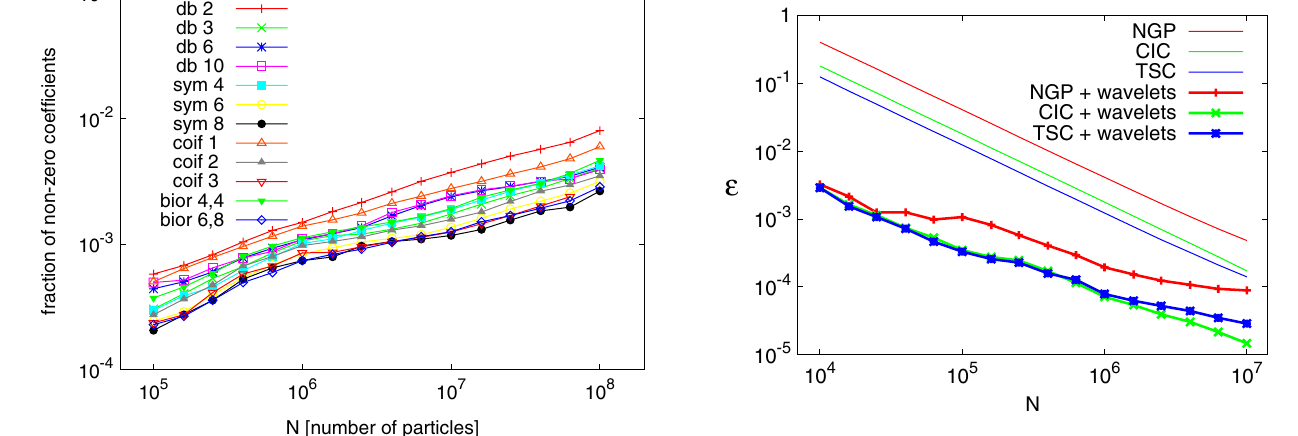
FIG. 6. Accuracy of the approximation (measured by the IMSE) as a function of the number of particles N for the three lowest-order CDS: NGP (thin red line), CIC (thin green), and TSC (thin blue) for the sinusoidally modulated flattop distribu- tion used in Sec. IV. The thick lines correspond to the wavelet- denoised distribution for